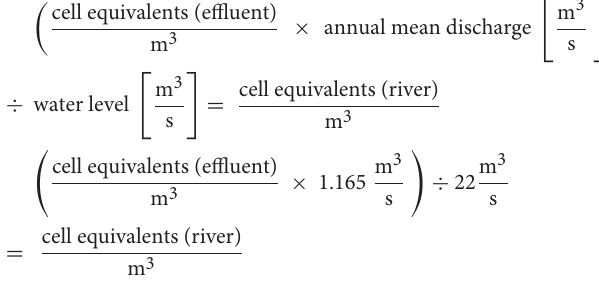
system at different water level scenarios (low water, mean water, and flood